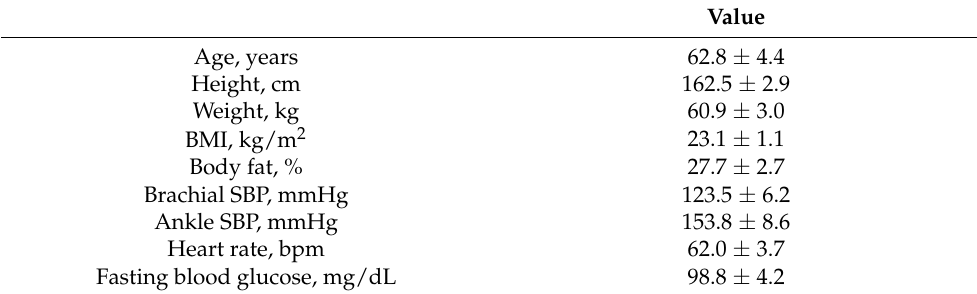
Table 1. Baseline characteristics of the